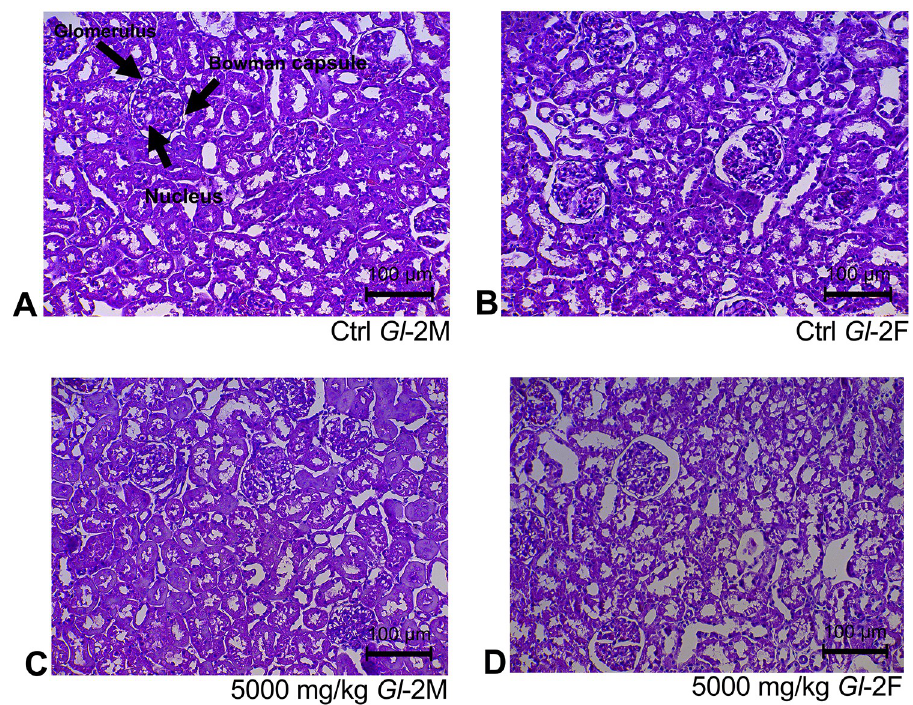
Fig 4. Kidney tissue stained with hematoxylin and eosin, showed no kidney damage in male (M) and female (F) Wistar rats after consuming the standardized Gl -2 extract of Ganoderma lucidum for 14 experimental days. A–B: Control (Ctrl) groups. C–D: Treated groups consuming the 5000 mg/kg bw/day